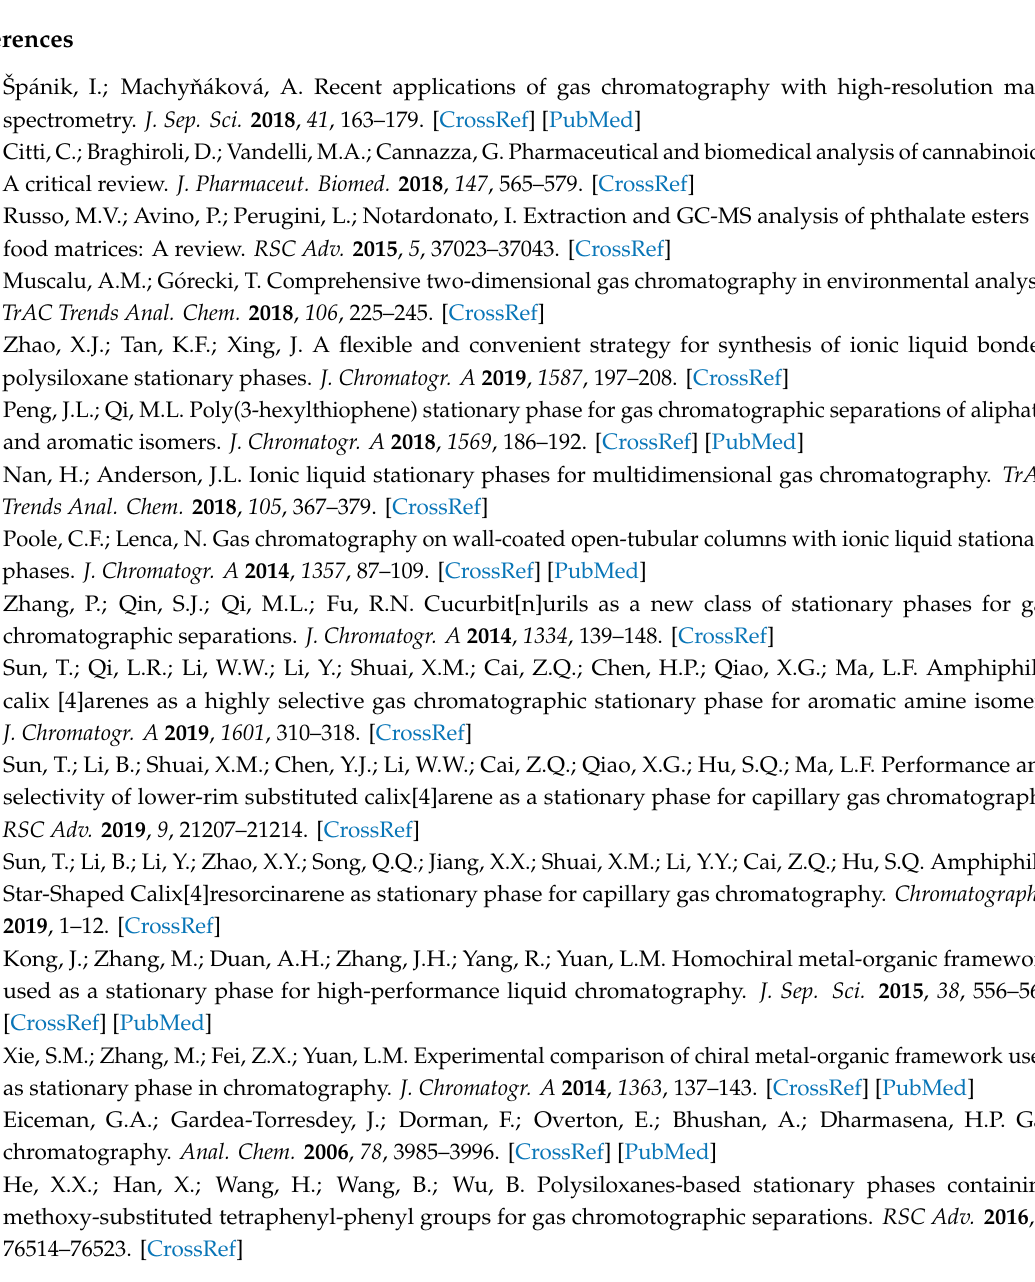
Supplementary Materials: The following are available online, Figure S1: FT-IR spectra of the PCL-PEG-PCL, Figure S2: 1 H-NMR spectrum (CDCl 3 ) of the PCL-PEG-PCL, Figure S3: GC separations of toluidine isomers on the PCL-PEG-PCL (10 m × 0.25 mm) column in comparison to the HP-5 (10 m × 0.25 mm), DB-17 (30 m × 0.25 mm), and DB-1701 (30 m × 0.25 mm) commercial columns. Table S1: Solutes and their descriptors for determining the system constants of the stationary phases by the Abraham solvation parameter